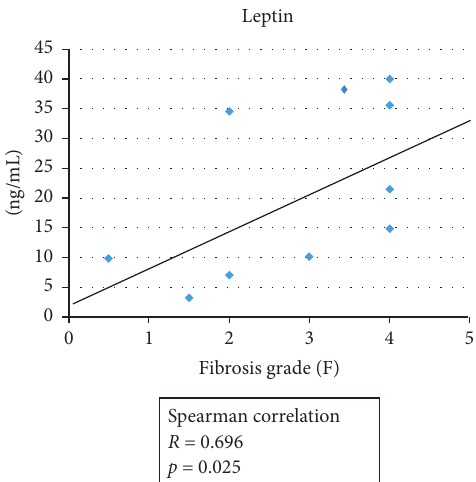
Figure 3: The association between the patients’ serum adiponectin level and hepatic fibrosis grade ( n � 10). Spearman’s correlation was obtained. A significant association was observed ( p � 0 . 025, R �